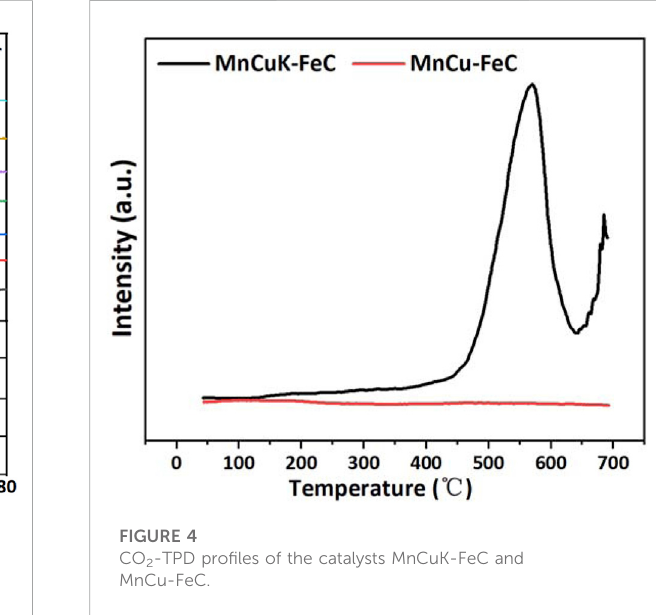
FIGURE 4 CO 2 -TPD pro fi les of the catalysts MnCuK-FeC and